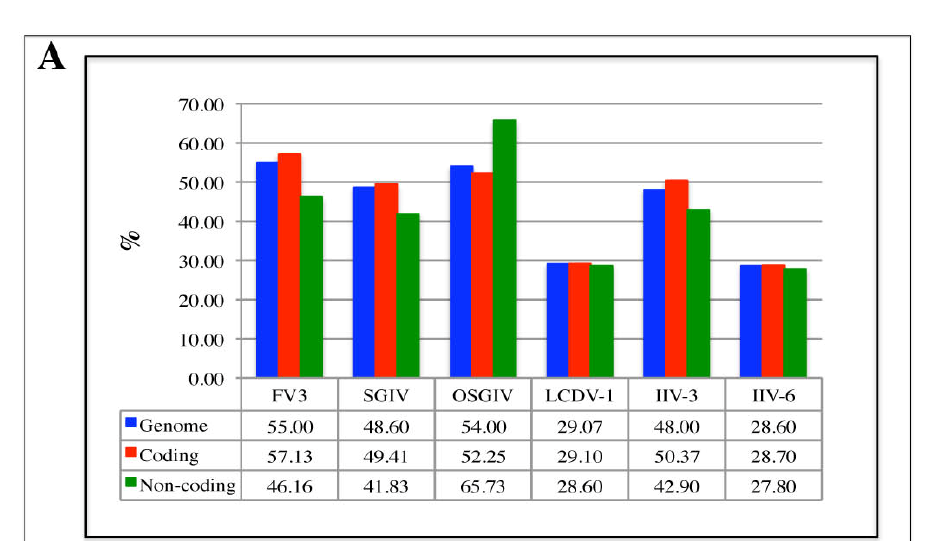
Figure 2. Different iridoviruses exhibit different trends in G/C content of coding versus non-coding regions. G/C content of coding regions was determined using the VGO software. The length and G/C content of the coding regions and overall length and G/C content was used to determine the G/C content of the non-coding regions. (A) Overall G/C content is shown in blue, coding region G/C content is shown in red, and non-coding G/C content is shown in green. (B) Images for one representative virus from each genus are displayed showing changes in G/C content (red line) in selected coding (blue bars) and non-coding regions of the genome. Average genome G/C content is displayed in